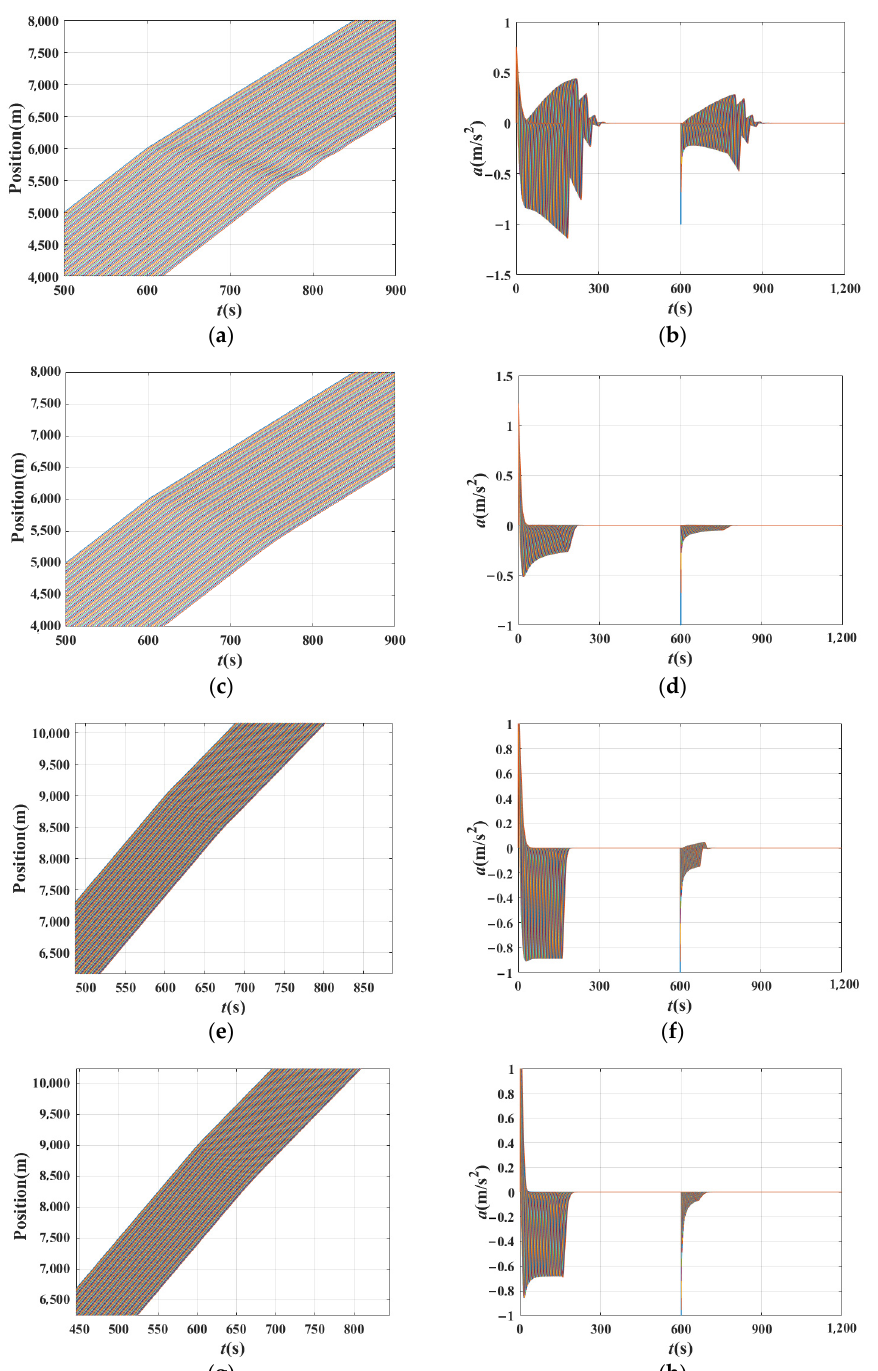
Figure 6. Time–position and acceleration changes in the traffic when basic model is the IDM. ( a ) Time–position of the traffic when β 1 = 0, β 2 = 0, T = 1.5 s; ( b ) Acceleration changes in the traffic when β 1 = 0, β 2 = 0, T = 1.5 s; ( c ) Time–position of the traffic when β 1 = 0.4, β 2 = 0, T = 1.5 s; ( d ) Acceleration changes in the traffic when β 1 = 0.4, β 2 = 0, T = 1.5 s; ( e ) Time–position of the traffic when β 1 = 0.3, β 2 = 0, T = 0.6 s; ( f ) Acceleration changes in the traffic when β 1 = 0.3, β 2 = 0.0, T = 0.6 s; ( g ) Time– position of the traffic when β 1 = 0.3, β 2 = 0.2, T = 0.6 s; ( h ) Acceleration changes in the traffic when β 1 = 0.3, β 2 = 0.2, T = 0.6